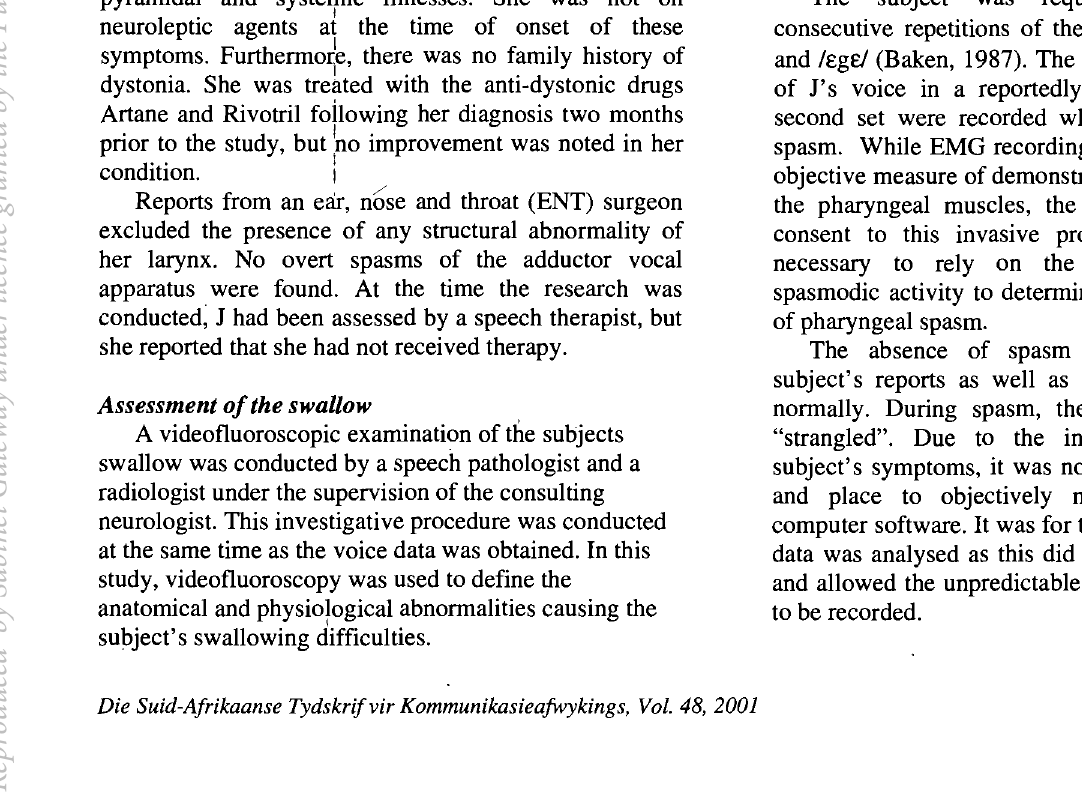
consecutive repetitions of the VCV phrases lebEl,